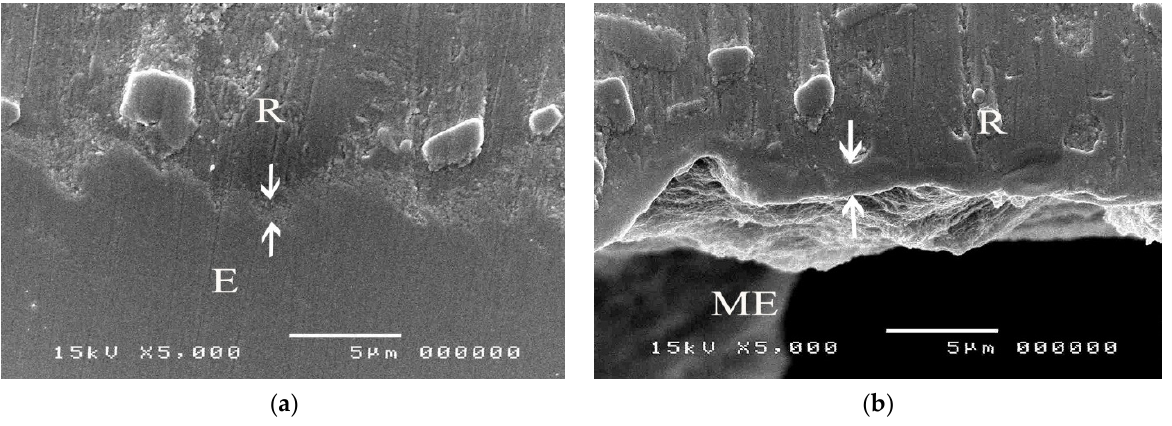
Figure 6. SEM micrographs of fractured experimental biopolymer bonded with Super-Bond demonstrating the consistent thickness of the hybrid layer (arrowed) at the prosthesis-luting resin interface in ( a ) polished and ( b ) chemically challenged specimens (original ×5000, E = experimental biopolymer, R = resin, ME = modified experimental biopolymer).